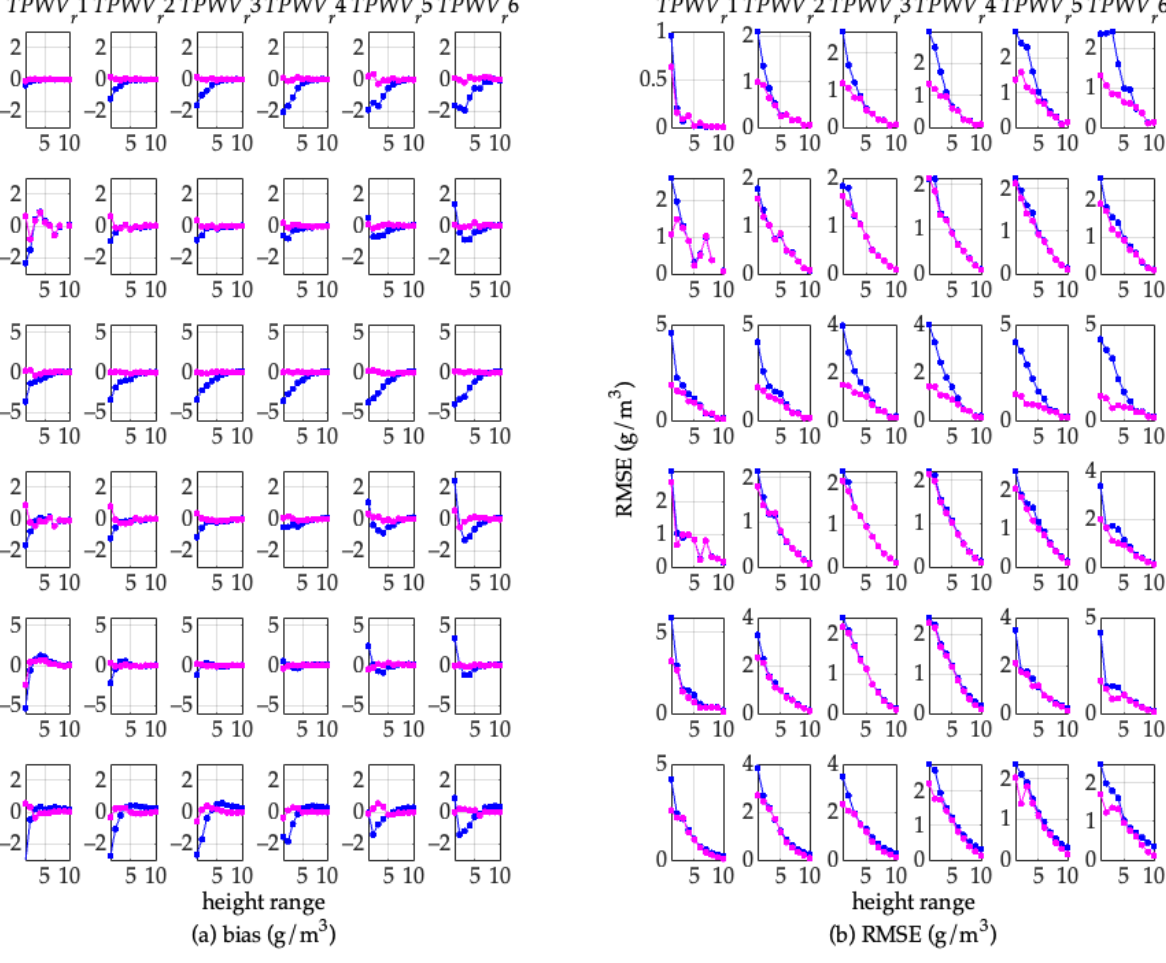
Figure 6. Annual biases ( a ) and RMSEs ( b ) of ρ wm and ρ wH resulting from the two models and TPWV in each of 10 height ranges within six TPWV r at six selected stations (with serial numbers 1, 4, 5, 6, 9, and 12, instead of using the name of the stations for convenience). The blue and magenta dotted lines are the results of the exponential model and the new model, respectively.